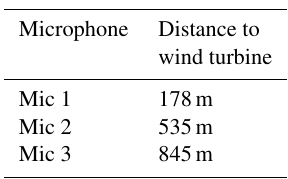
Figure 1. Overview map of the wind farm and detailed measure- ment plan including the position of a specific wind turbine, acousti- cal measurement stations and a meteorological mast. Table 1. Horizontal distances from wind turbine to acoustic mea- surement